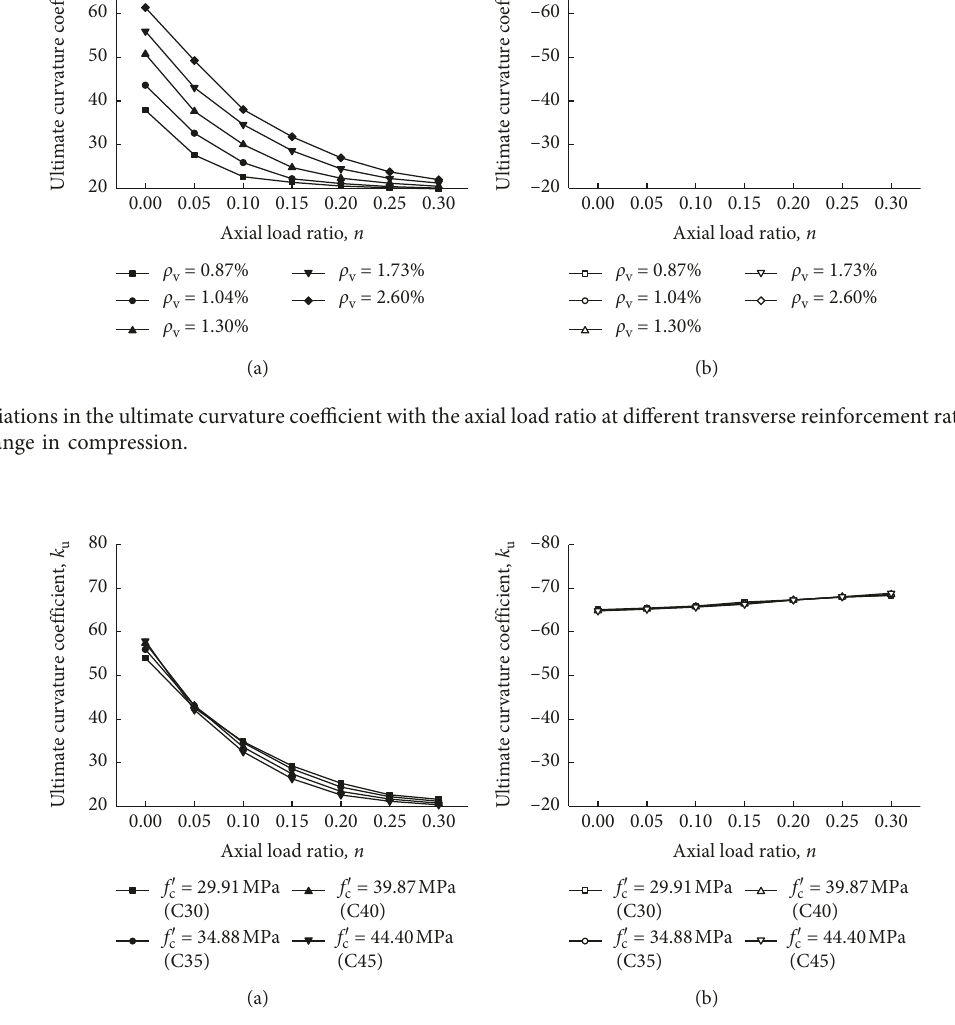
Figure 16: Variations in the ultimate curvature coefficient with the axial load ratio at different concrete strengths. (a) Flange in tension. (b) Flange in